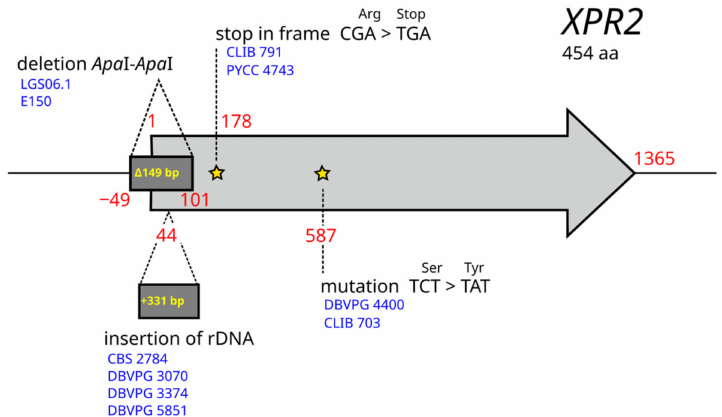
Figure 7. Nucleotide variations found in XPR2 . Comparison is relative to gene YALIH222S02e00408g of Y. lipolytica strain H222. Variants specific to strains showing no halo on the skimmed milk medium are shown. Yellow stars indicate the nucleotide position of the